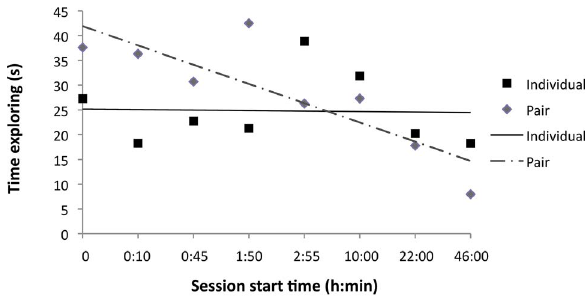
Figure 3. Mean time spent exploring novel object for individual and paired calves. Calves were exposed to a novel object over 8 sessions and time spent exploring was recorded (back- transformed from square-root). Exploration was defined as sniffing, licking, and pushing the object. Pair-housed calves ( n =10) showed a decline in exploration time over repeated sessions separated by increasing time intervals ( p =0.032); individual calves ( n =8) showed no change.